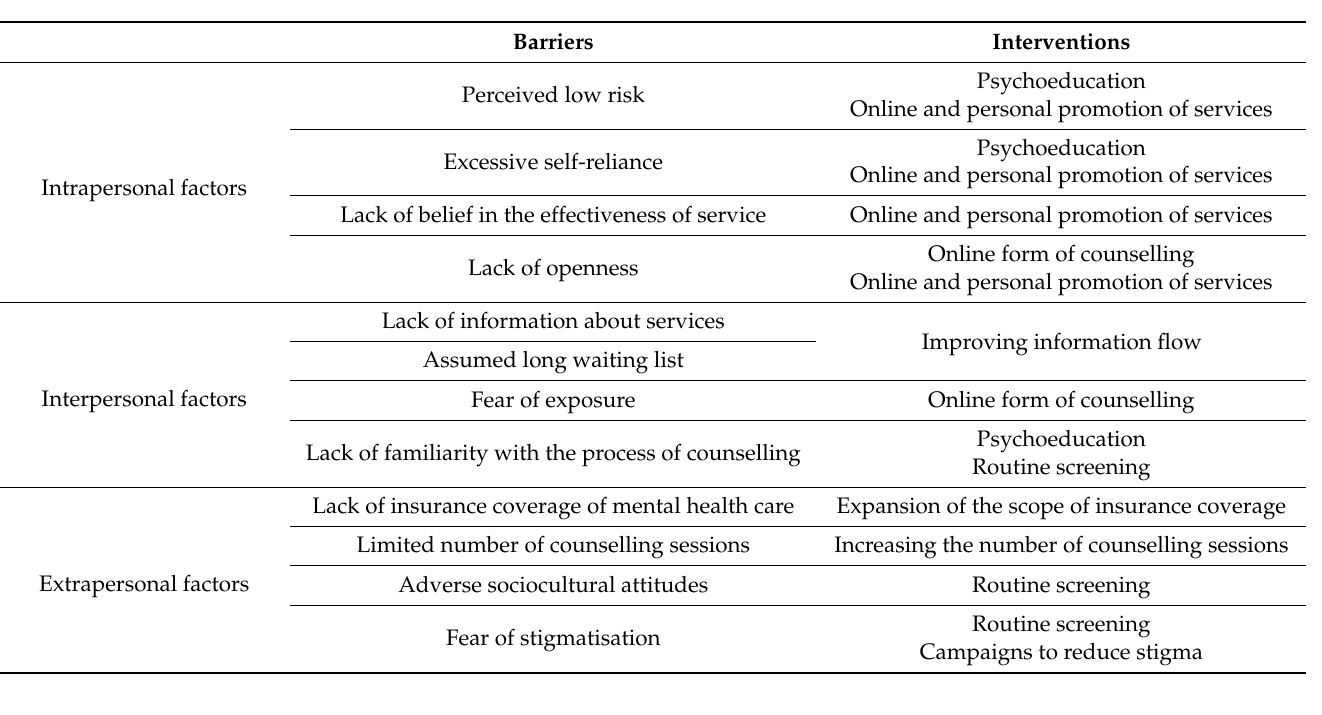
Table 2. Barriers of help-seeking at the University mental health services, and suggestions to reduce or eliminate